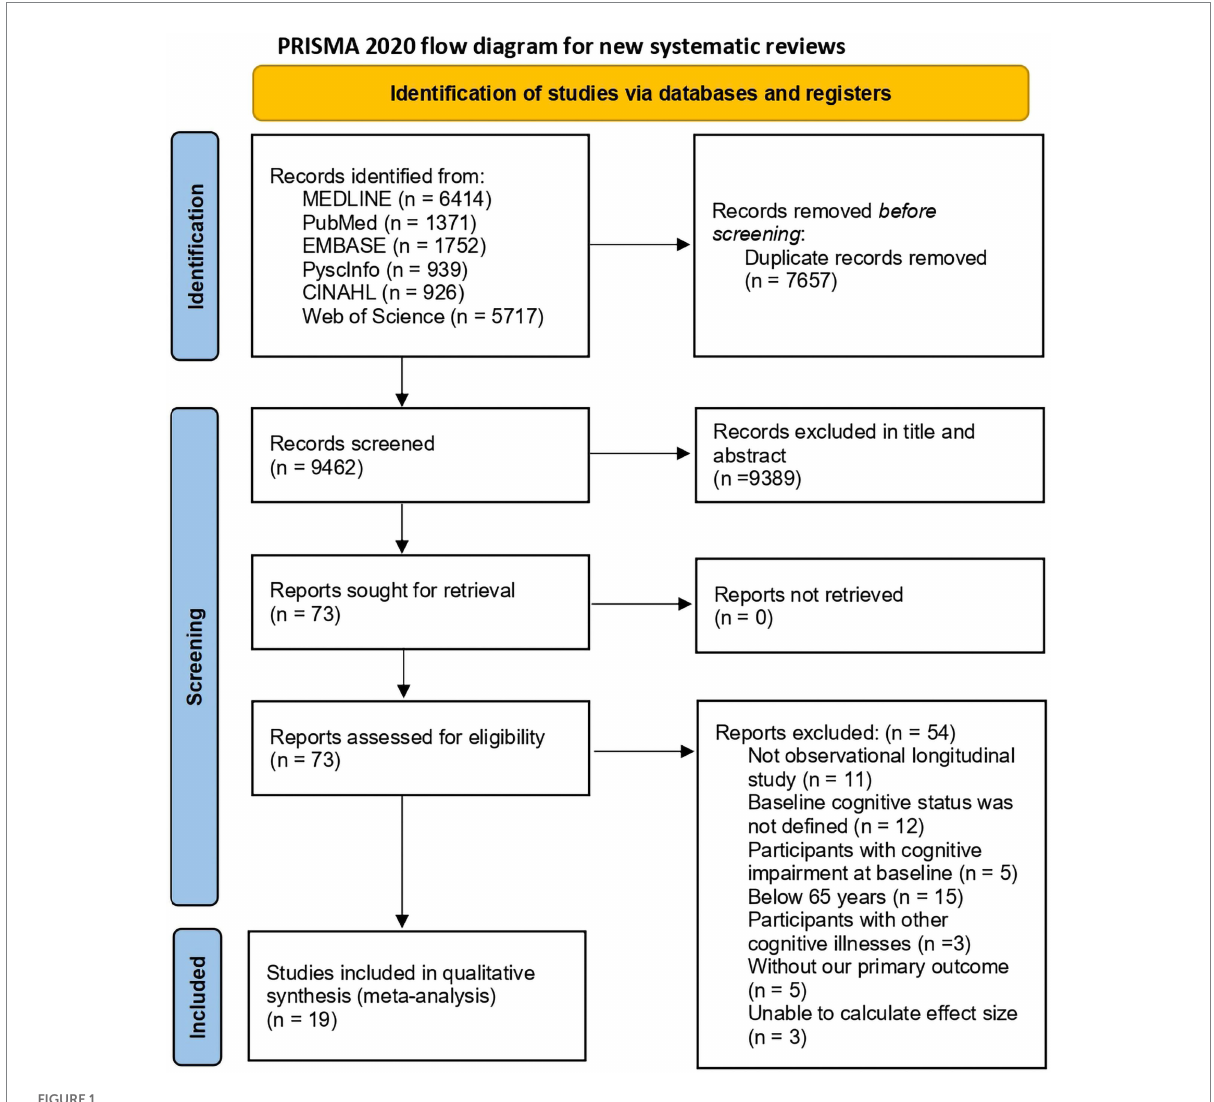
FIGURE 1 Flow chart of the selection process for this